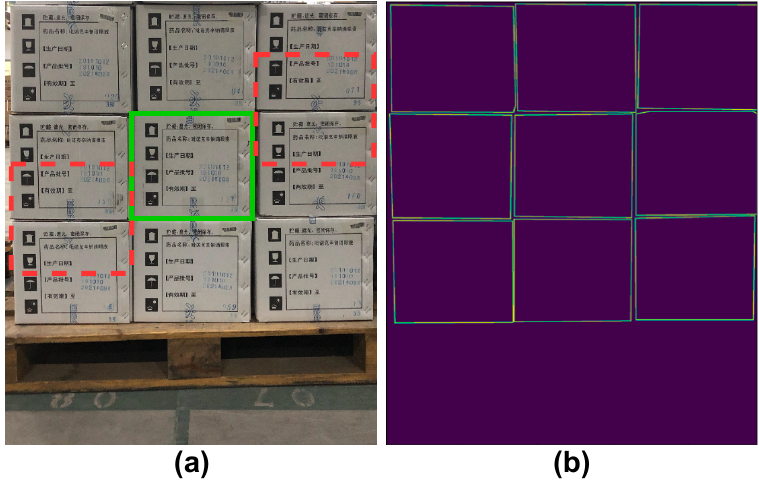
Figure 7. Illustration of the target boundary map that is extracted naturally from pixel-wise anno- tation. Green and red boxes in ( a ) represent correctly positioned boxes and error boxes that are confused by repeated texture. ( b ) is the binary image where the pixel value of the contour is